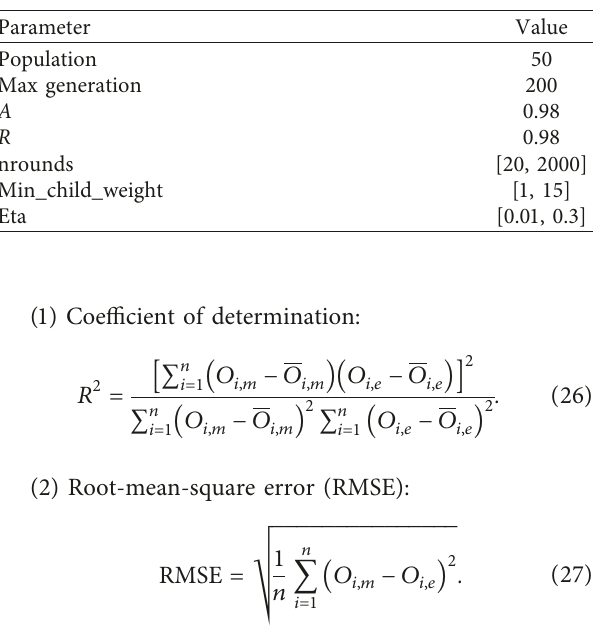
Figure 3: The structure of the XGBoost algorithm. Table 3: Parameter values of the Bat-XGBoost